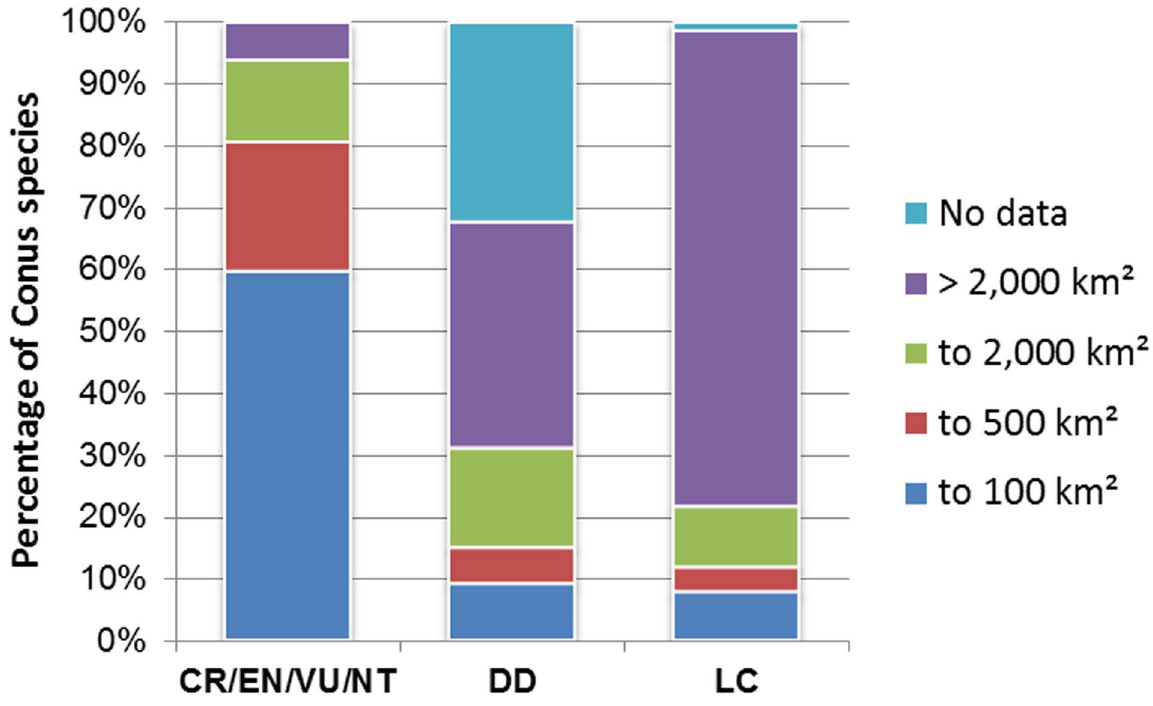
Figure 7. Contribution of range-restricted Conus species within assessment categories. This shows the percentage of species by assessment category, with DD species having a higher proportion of taxa with small ranges compared to LC species and also with a large number of species with no distribution data. All threatened and near-threatened categories have been grouped. Key: CR Critically Endangered, EN Endangered, VU Vulnerable, NT Near Threatened, DD Data Deficient and LC Least Concern